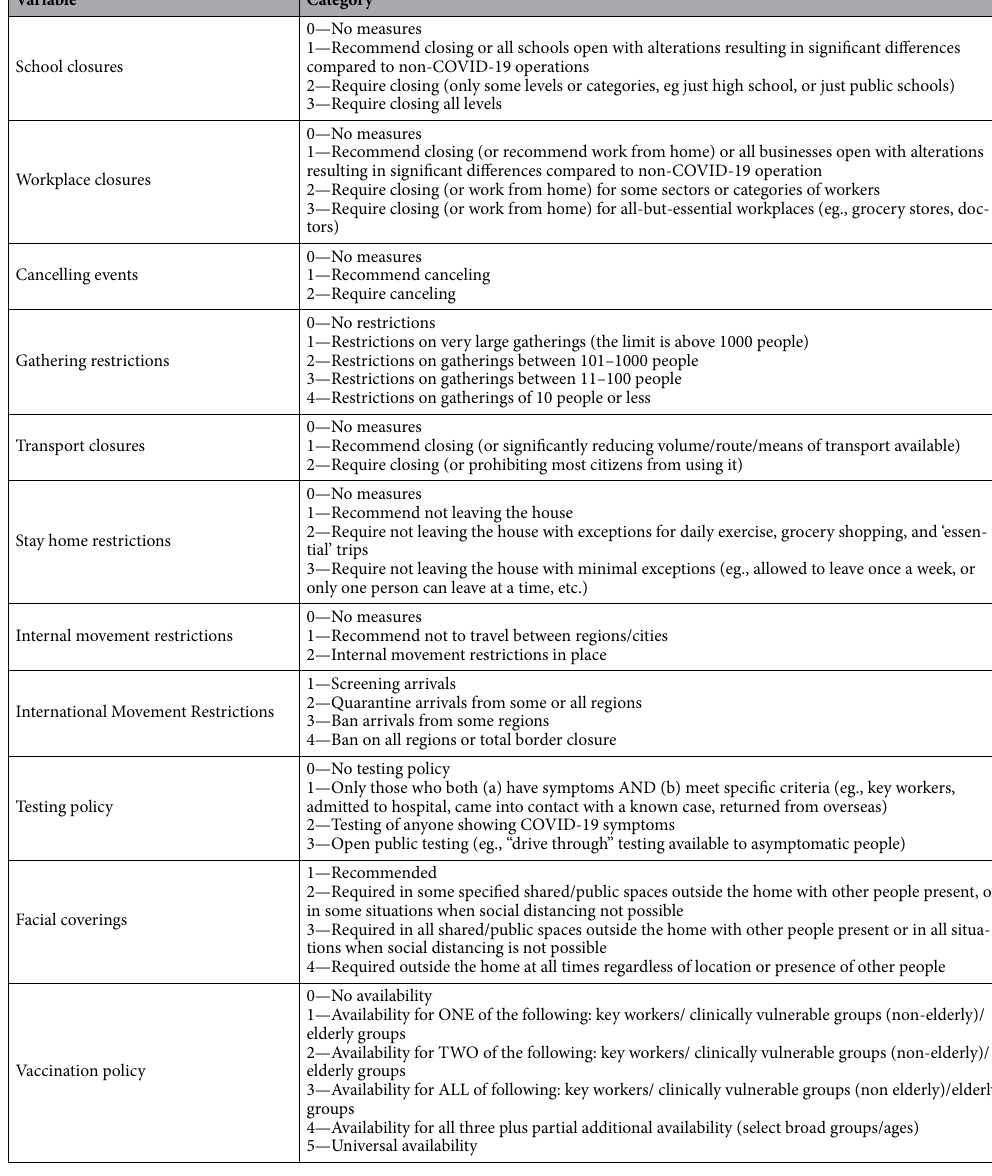
Table 1. Policy situations implemented by countries during the COVID-19